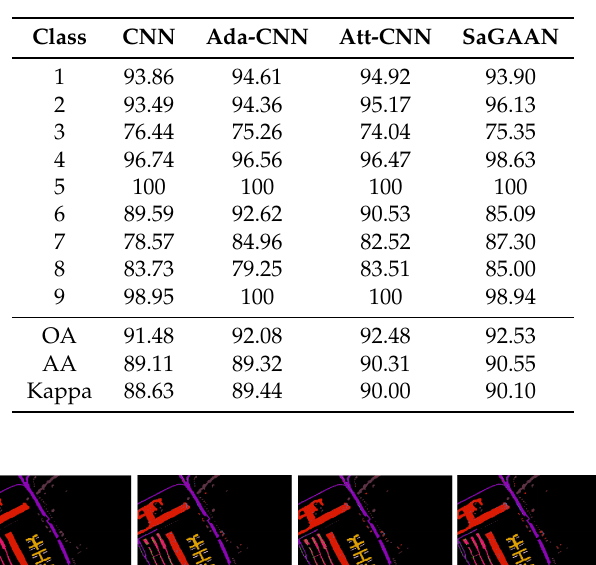
Table 2. Classification accuracies on Pavia University dataset.